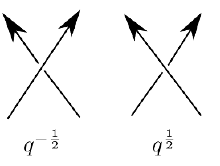
Figure 6. Rules for assigning powers of q to self-crossings of the lifted path.